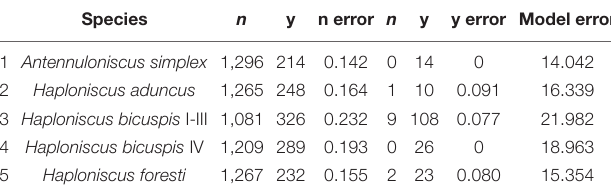
TABLE 2 | Model accuracy.